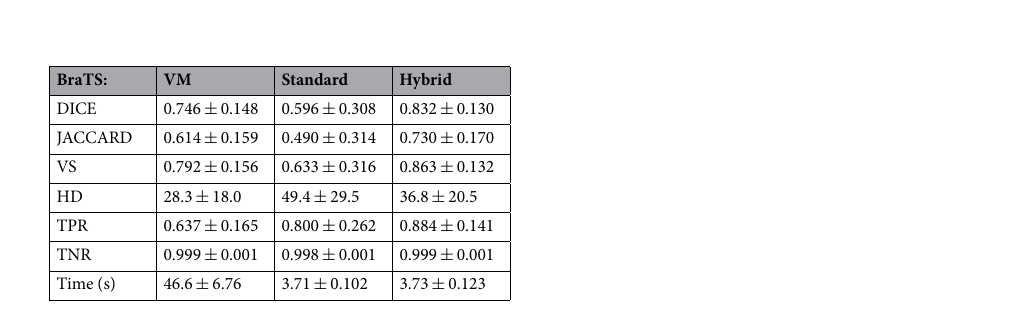
Table 4. Performance on segmentation metrics of the variational method (VM) only, and standard and hybrid pipeline in brain tumour segmentation. Units given as mean ± standard deviation.